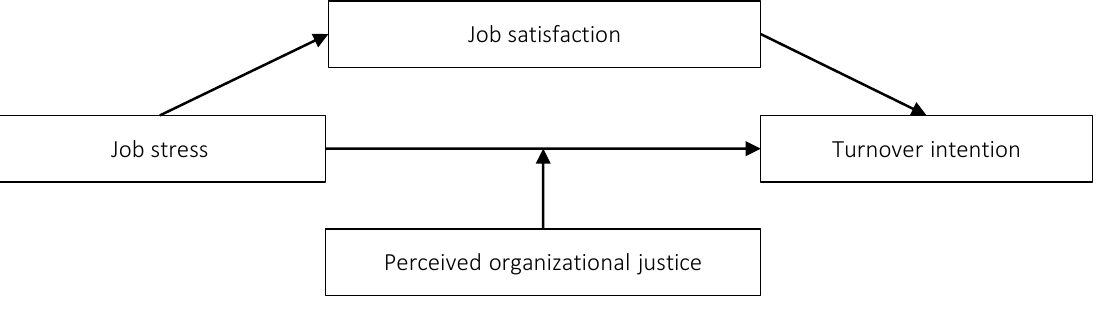
Figure 1. Research